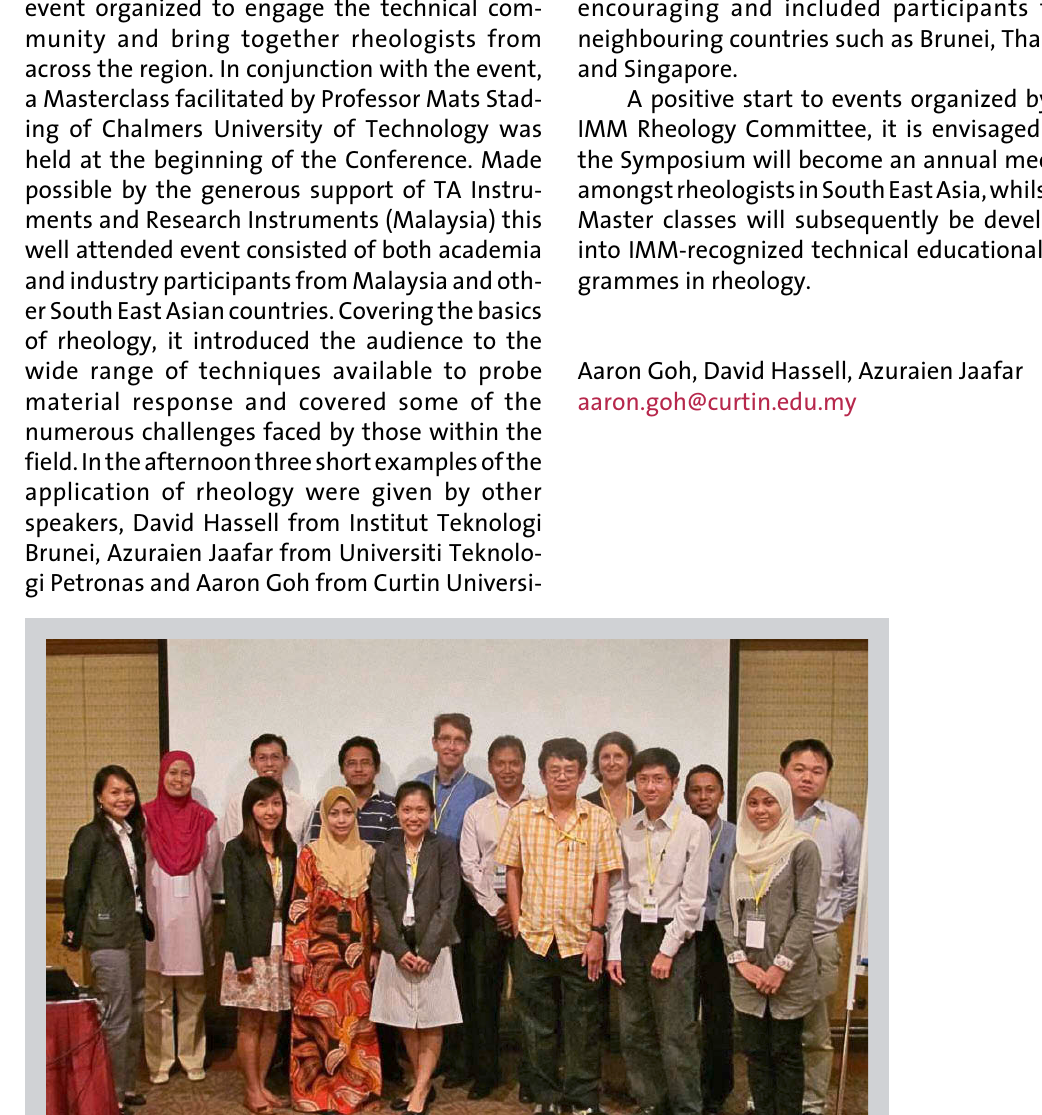
Figure 1: Participants at the Rheology